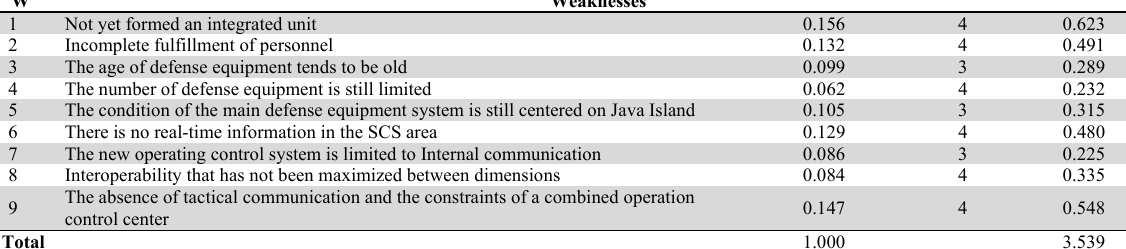
Scores and Weights for Internal Factors on Weakness